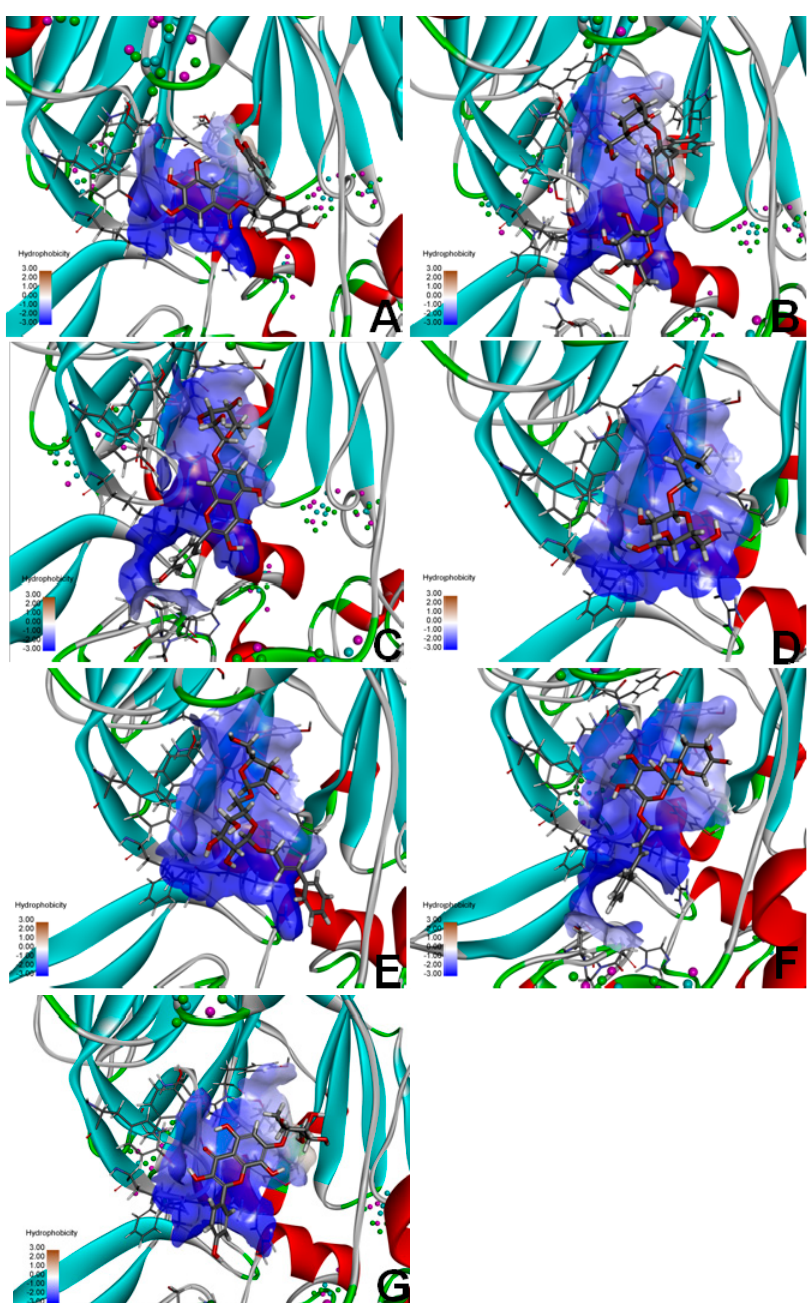
Figure 10. The docking results of the seven compounds interacting with the target protein fibroblast activation protein- α (FAP- α ). ( A ) 3,4,5-trihydroxybenzoic acid (2 S - cis )-3,4-dihydro-5,7-dihydroxy -2-(3,4,5-trihydroxyphenyl)-2 H -benzo[ b ]pyran-3-yl ester; ( B ) Herbacetin-3- O - β - D -glucopyranoside-7 - O - α - L -rhamnoside; ( C ), Kaempferol-7- O - α - L -rhamnoside; ( D ) Rhodiocyanoside A; ( E ) Rosarin; ( F ) Rosavin; ( G ) Rhodionin.